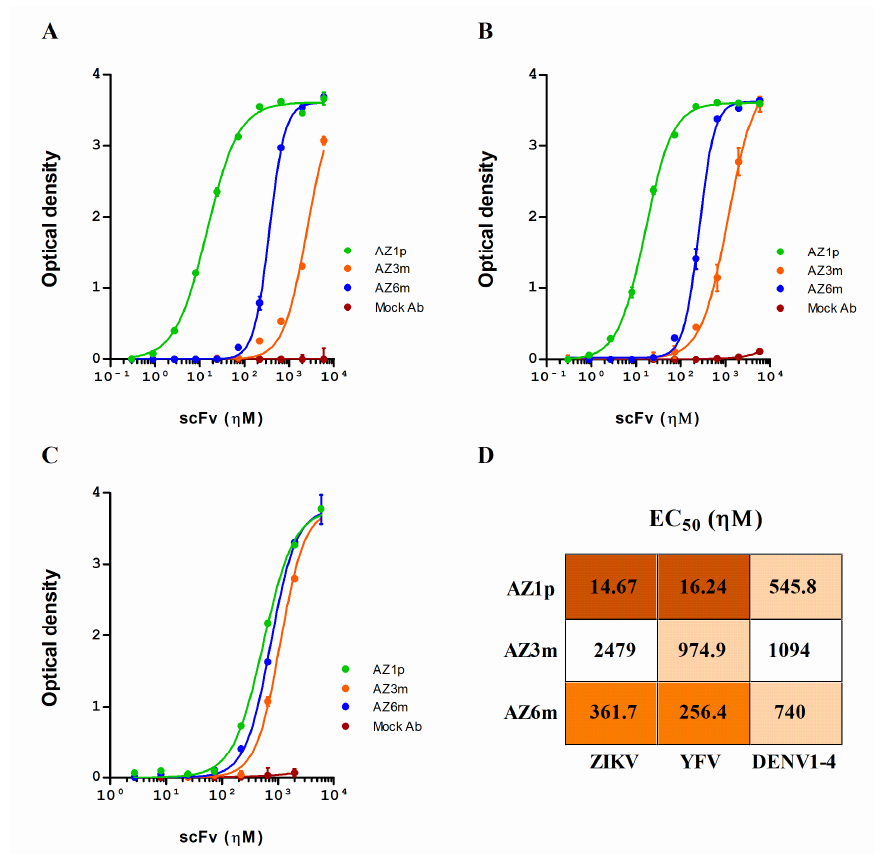
Figure 5. Anti-flavivirus binding activity of the selected scFvs. Recombinant scFvs (AZ1p, AZ3m, and AZ6m) were analyzed for their ability to bind to ZIKV ( A ), YFV ( B ), and an equal mix of the four DENV serotypes ( C ). In these experiments, the plates were coated with the whole viral particles. The half effective concentration (EC 50 ) for each scFv against each flavivirus was also determined ( D ). Data are presented as mean +/ − SD and are representative of replicates from at least three independent experiments. An unspecific scFv was used as a negative antibody (Mock Ab).